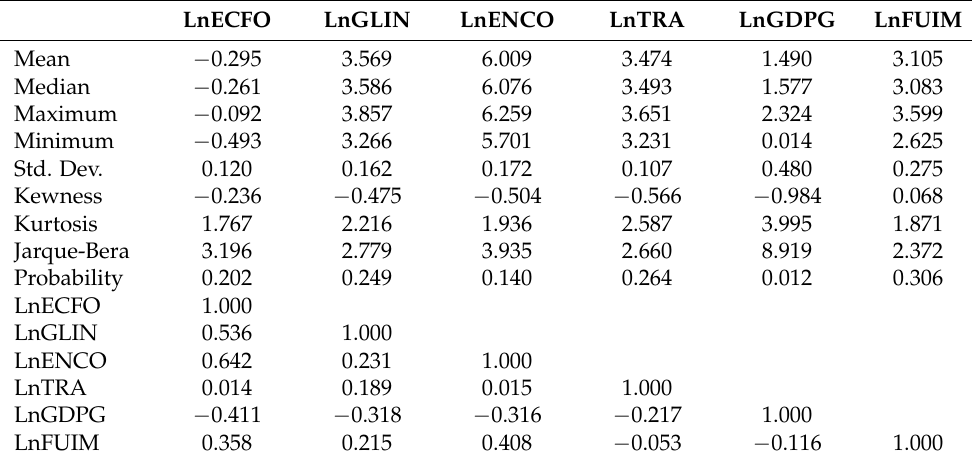
Table 1. Summary analysis and correlation analysis